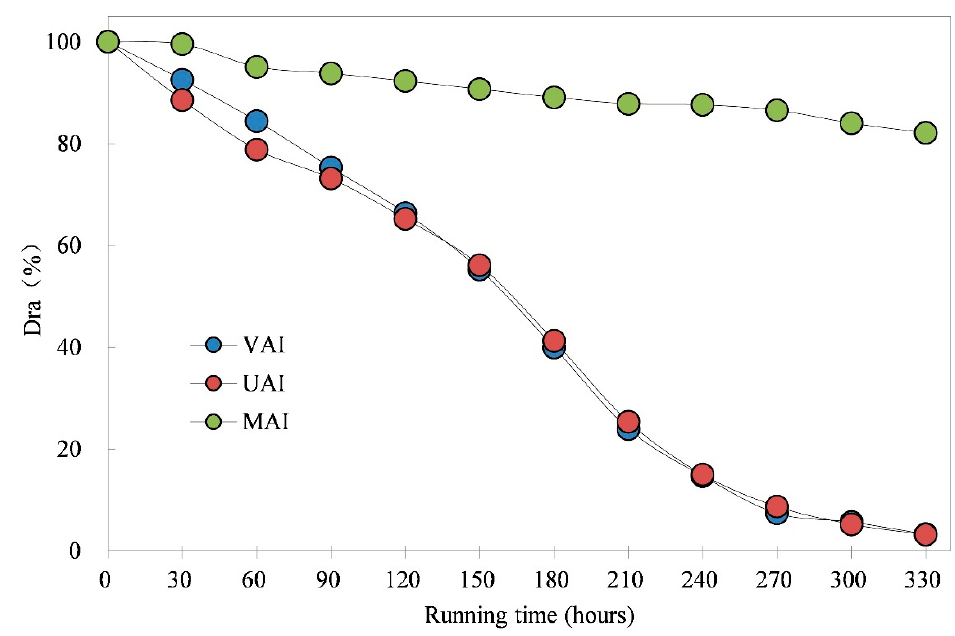
Figure 2. Change in average discharge ratio Dra of emitter with irrigation time.